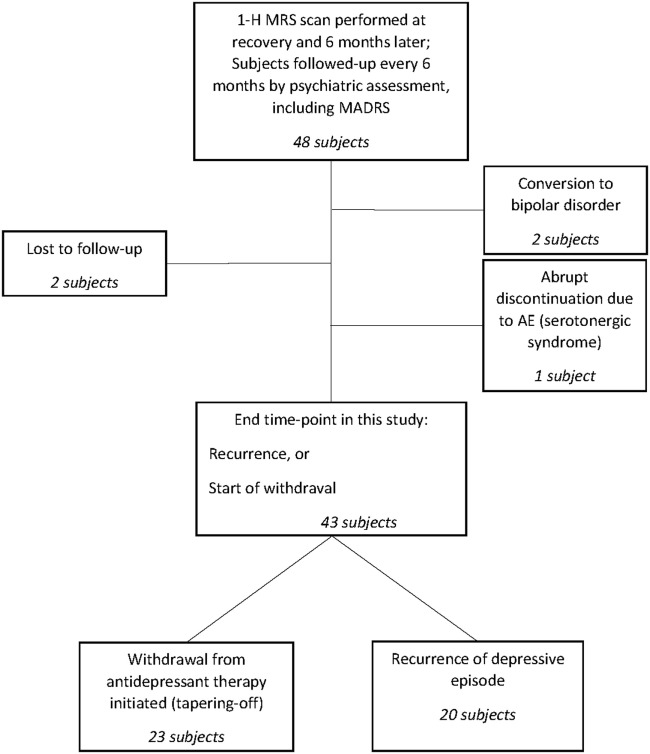
Study schematic.